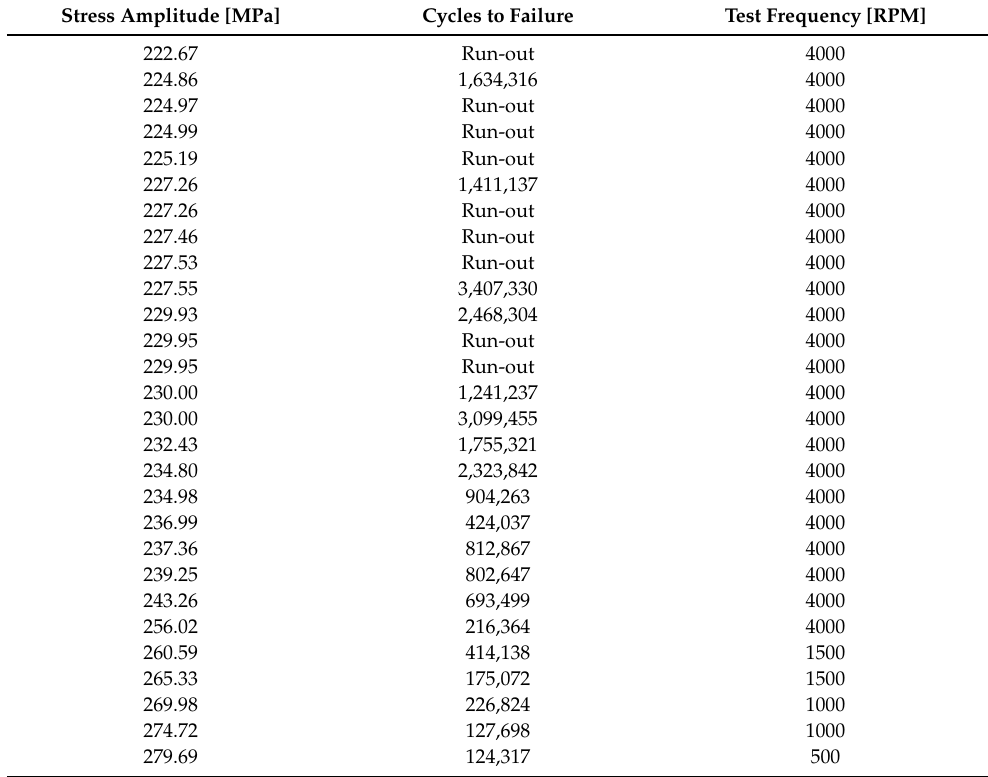
Table A2. Experimental results constant amplitude loading, specimens extracted from the rolling direction.